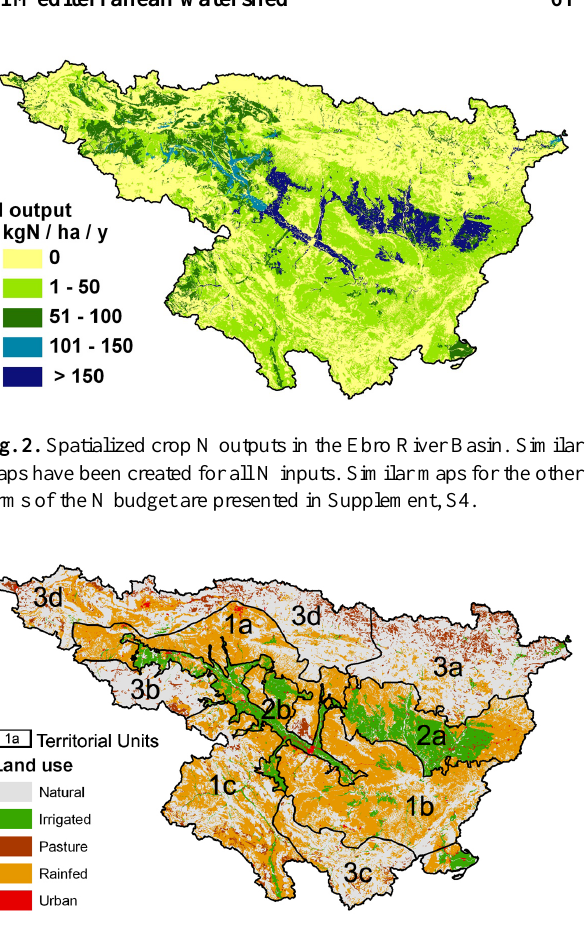
Fig. 3. Territorial units selected to calculate detailed N